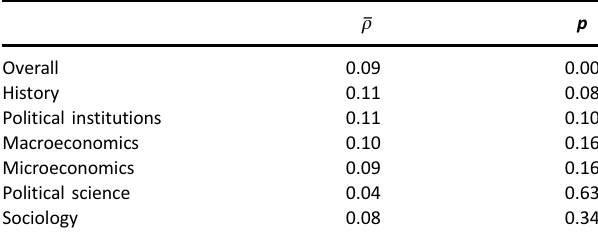
Table 3. Average correlation between SET and instructor gender